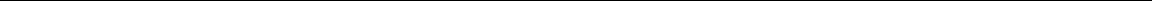
Fig. 4 Wisp colocalizes and interacts with Aub. a , b Immunostaining of UASp-GFP-Aub nos-Gal4 stage 10 oocytes, also stained with DAPI ( blue ) ( a ) and 0 – 2 h-embryos ( b ), with anti-GFP and anti-Wisp. Posterior poles are shown in the bottom panels in a , and in b . Quanti fi cation of colocalization in the germ plasm using the Manders coef fi cient is shown in b . Scale bars: 30 μ m in a top panels, and 10 μ m in a bottom panels and in b . c Immunostaining of UASp- GFP-Aub/nos-Gal4 0 – 2 h-embryos with anti-GFP and either anti-CCR4 (top panels), or anti-Smg (bottom panels). Scale bars: 10 μ m. d Co- immunoprecipitation of Wisp with GFP-Aub in UASp-GFP-Aub/nos-Gal4 0 – 2 h-embryos. w 1118 0 – 2 h-embryos were used as negative control (Mock). Immunoprecipitation was with anti-GFP (GFP IP) either in the presence (+) or the absence ( − ) of RNase A. e Co-immunoprecipitation of Aub with Wisp in wild-type, csul and tud mutant 0 – 2 h-embryos. Immunoprecipitation was with anti-Wisp in the presence of RNase A. Bound proteins were detected using western blots with anti-Wisp and anti-Aub; inputs correspond to protein extracts before IP in d , e . f GST pull-down assays between GST-Wisp and HA- Aub. Constructs and interactions are shown in the table. HA-tagged Aub fragments were revealed using western blot with anti-HA. Inputs correspond to 1:10 of in vitro-synthetized HA-Aub fragments before pull-down. GST alone was used as a negative control. GST and GST-recombinant proteins used in each pull-down are shown (bottom panels). Arrowheads indicate full-length recombinant